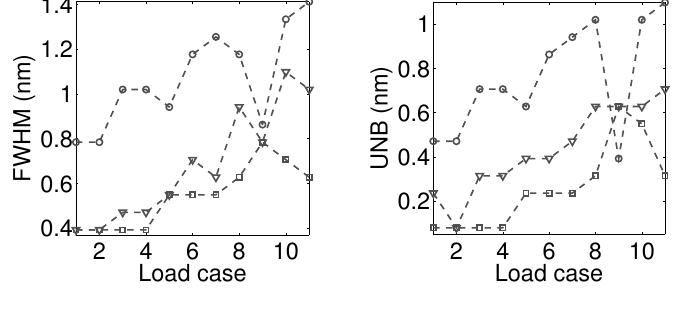
Figure 11. FWHM ( left ) and UNB ( right ) indices vs . load case for FBG1 (circle), FBG2 (square) and FBG3 (triangle). The maximum FWHM obtained is 1.41 nm.